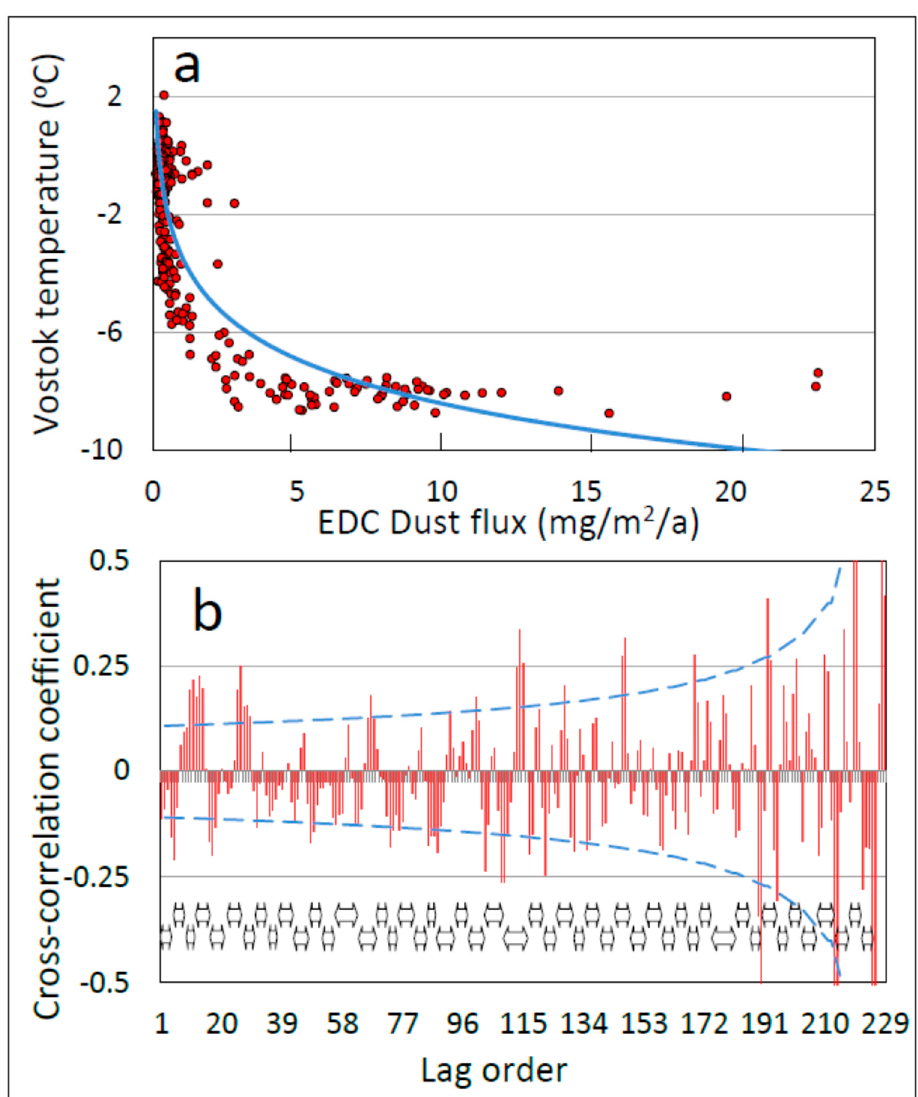
Figure 10. The relationship between dust flux at EPICA Dome C (EDC) and temperature proxies at nearby Vostok from the Last Glacial Maximum (LGM) to the late Holocene, for the time period 21,969–397 years before 1950 (Yb1950). ( a ) Scatterplot showing the logarithmic relationship. ( b ) Cross-correlogram of temperature and wind proxies. Horizontal open arrows designate visually identified centennial-scale periodicities in the cross-correlogram. The dashed blue lines in part b represent 95% confidence limits (positive and negative) for the value of the correlation coe ffi cient associated with di ff erent lag orders (sample